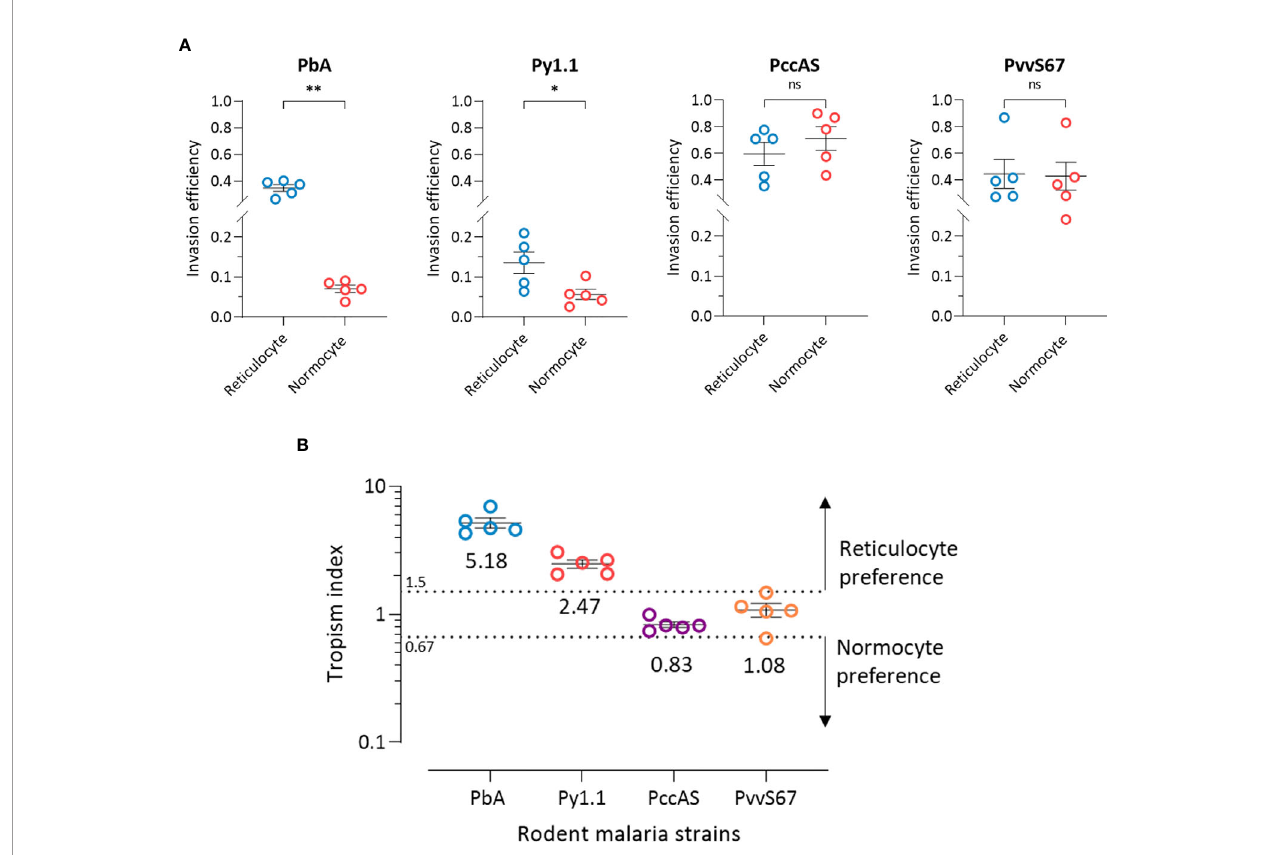
FIGURE 4 | Ex vivo tropism of rodent malaria strains at equal reticulocyte:normocyte ratio. (A) Reticulocyte and normocytes invasion ef fi ciencies (see Materials and Methods for calculation) were compared for all strains to determine erythrocyte preference. Data shown for each of the parasite strains are from 5 independent experiments. Error bars represent standard error of mean (SEM). ns, not signi fi cant; * p < 0.05; ** p < 0.01. (B) Tropism indices are derived from the invasion ef fi ciencies in (A) . Tropism index was calculated as the ratio of reticulocyte invasion ef fi ciency to normocyte invasion ef fi ciency. Dotted lines at tropism index = 0.67 and 1.5 represent the boundaries of mixed tropism, as determined by the spread of PccAS ’ s and PvvS67 ’ s data. Tropism indices of > 1.5 indicate a preference for reticulocytes and tropism indices of < 0.67 indicate normocyte tropism. The mean tropism indices are shown, and error bars represent SEM. PbA, P. berghei